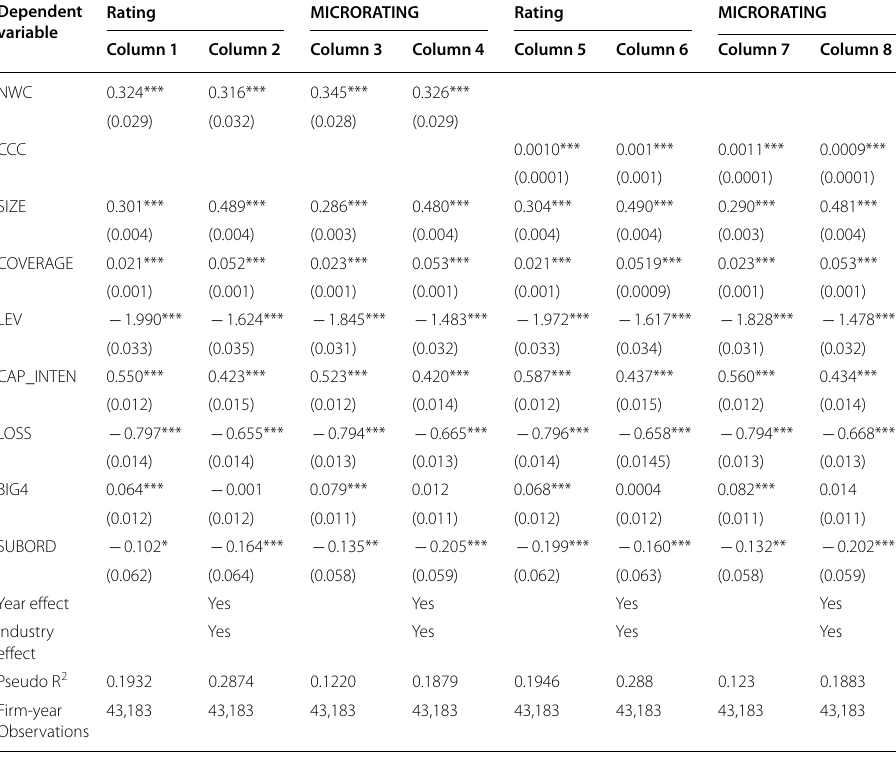
Variables definitions are provided in Table 2. Note: standard errors are reported in parentheses. ***, **, and * indicate two- tailed significance at the 1%, 5%, and 10% levels. The results in this table are based on annual panel data of U.S. listed firms from WRDS merged with CRSP/Compustat files for the period between 1985 and